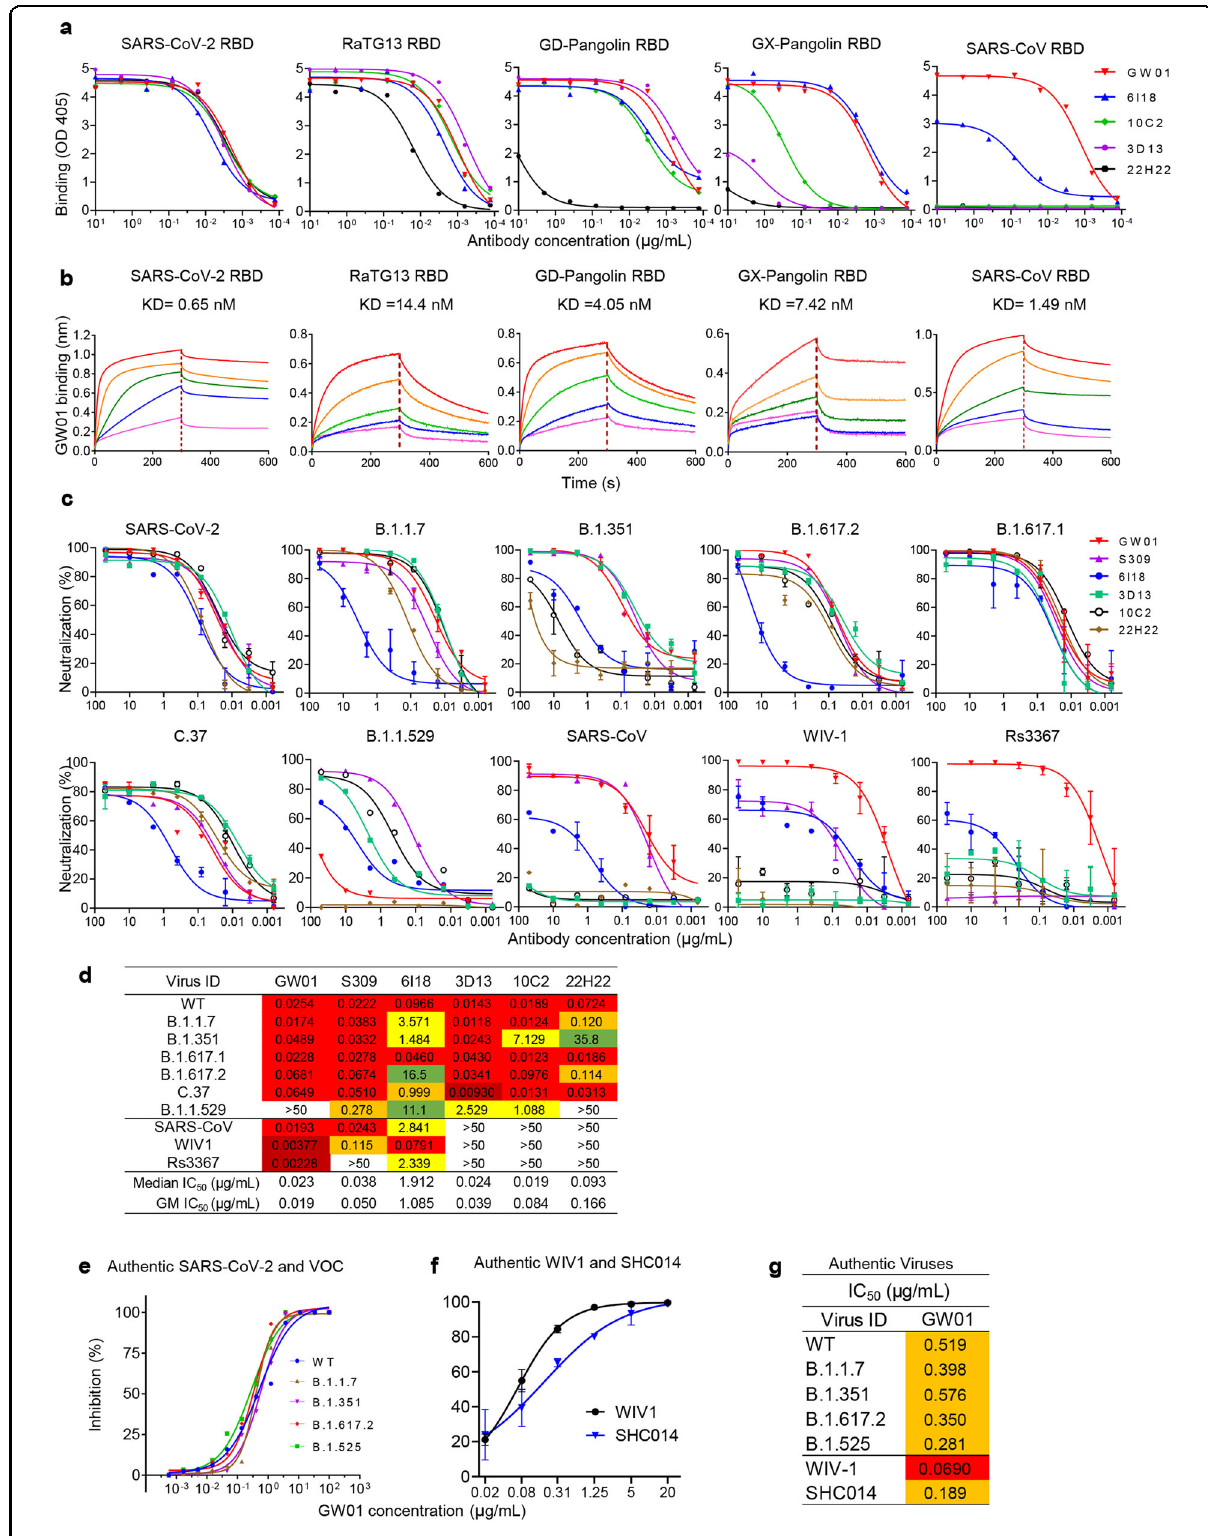
Fig. 1 (See legend on next